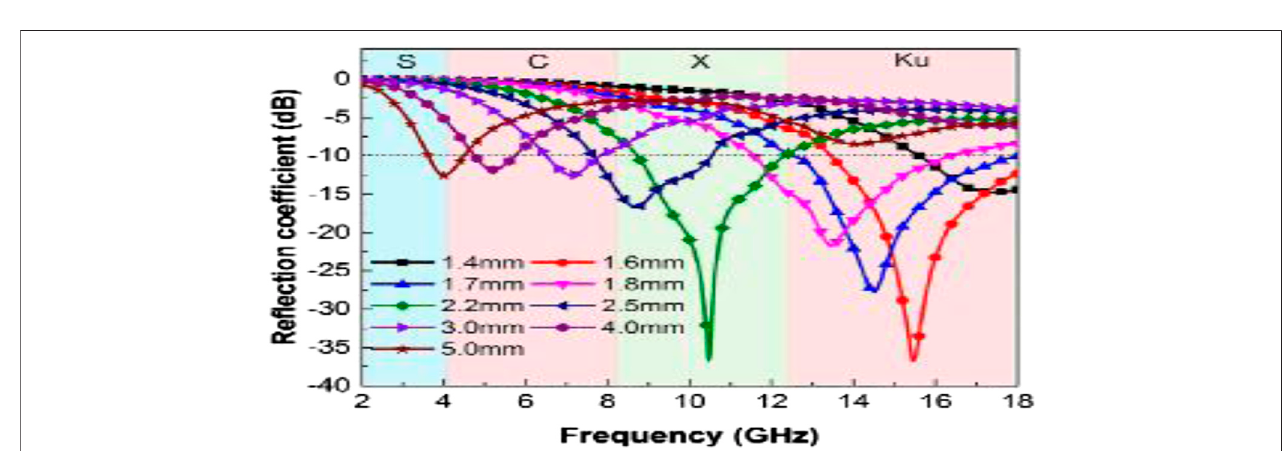
FIGURE 9 | Re fl ection coef fi cient of (a) 45 wt% C/TiO 2 hybrids (S-800) (Han et al., 2017).